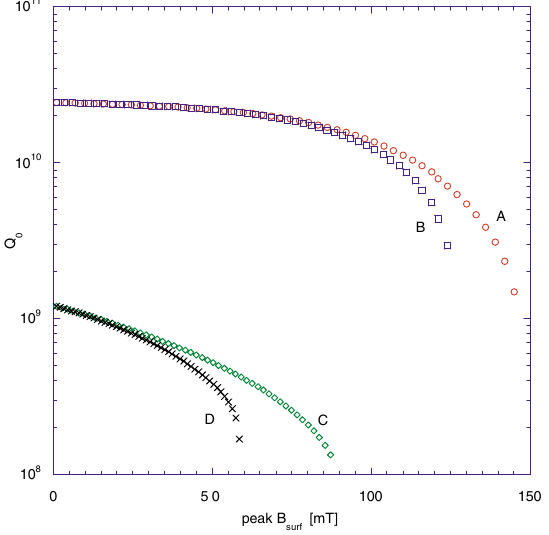
FIG. 5. (Color) Performance comparison computed for a TRASCO 700 MHz cavity. Simulation parameters are f (cid:3) (cid:3) 10 n(cid:22) , Cu thickness (cid:3) 4 mm , 707 MHz , G (cid:3) 250 (cid:22) , R res and RRR (cid:3) 275 . ( A ) and ( B ) are, respectively, bath and pipe (cid:3) 1 : 8 K , ( C ) and ( D ) are bath and pipe cooled at cooled at T l He (cid:3) 4 : 2 K . T l He